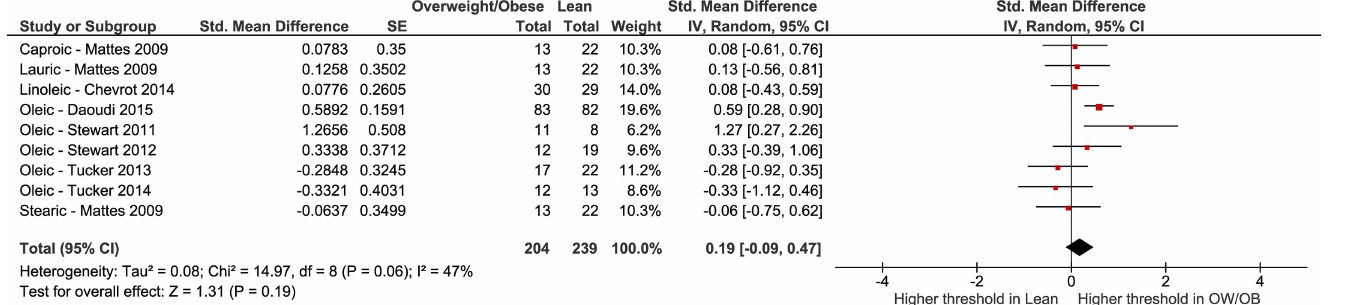
Fig 2. Forest plot of fatty acid taste thresholds of groups of participants who were lean versus overweight or obese from 7 included studies [6–